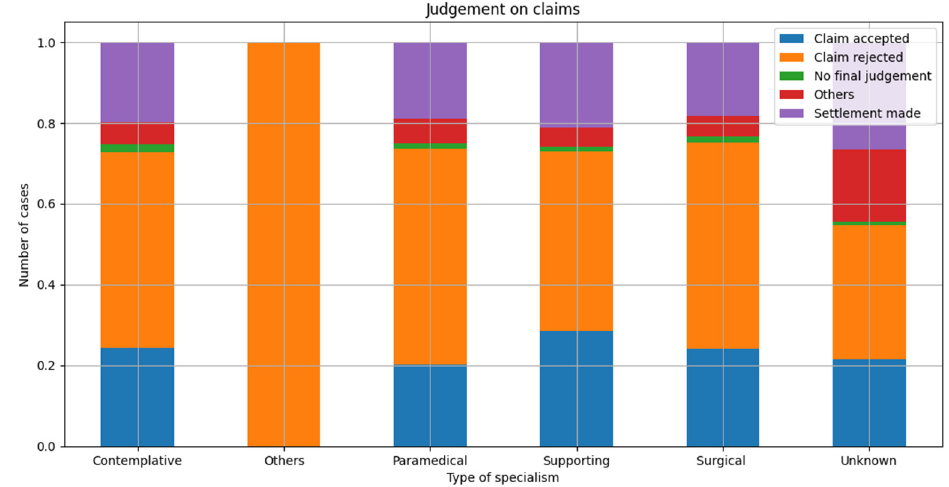
Figure 6. Final judgement per category medical specialty as relative distribution per final judgement.